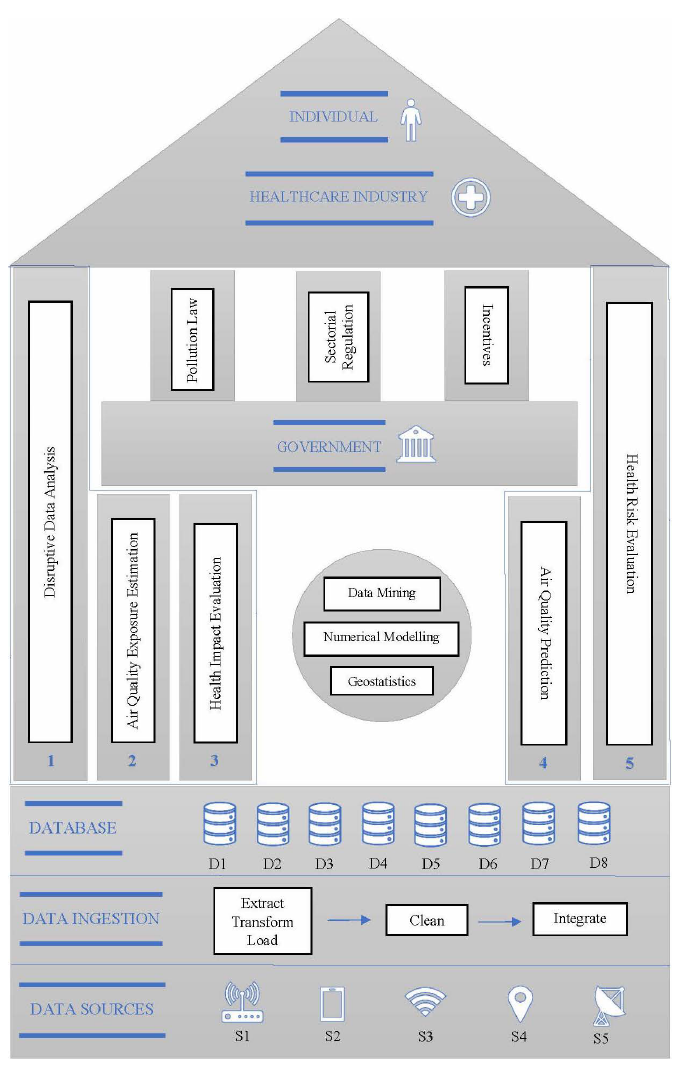
Figure 1. Proposed framework for the Air Quality Decision Support System